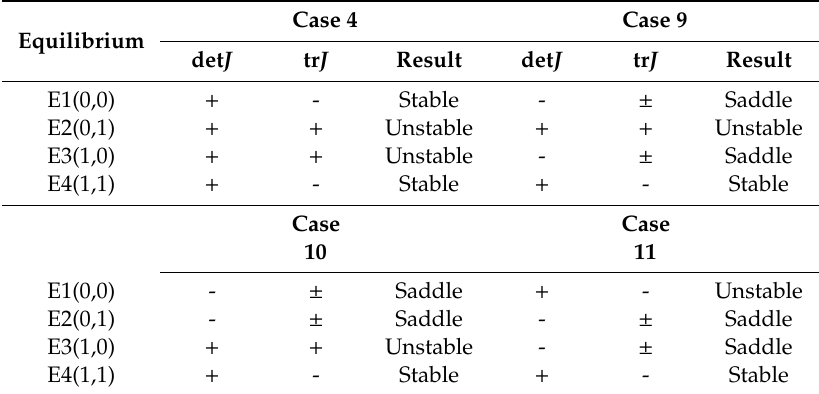
Table 9. Proposition 4: Analysis of local stability of